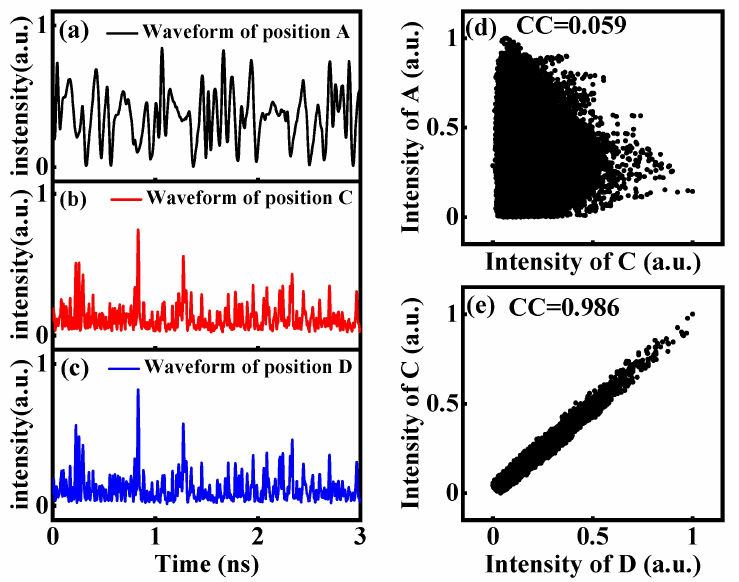
Figure 2. Temporal waveforms and the corresponding correlation plots of the output chaos. ( a – c ) show the normalized temporal waveforms of position A, C and D. ( d ) shows correlation plots of position A and C. ( e ) shows correlation plots of position C and